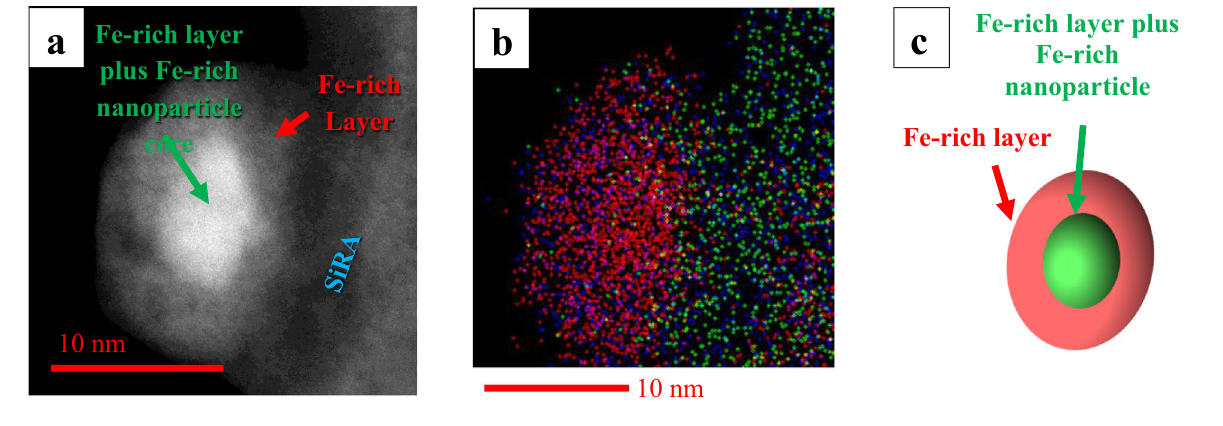
Figure 6. The structure of a nanoparticle lying on the SiRA of an interacted Ath particle extracted from AECs viewed in acSTEM-HAADF mode. ( a ) Core (bright grey) with an average Fe-valence state of 2.04, representing a mixture of core and layer (green arrow), and a “layer” (red arrow) with an average Fe-valence state of 2.40; ( b ) Fast EDXS map of the area seen in a) showing the Fe (red), O (blue), and Si (green) signals; ( c ) Simplified structure of a